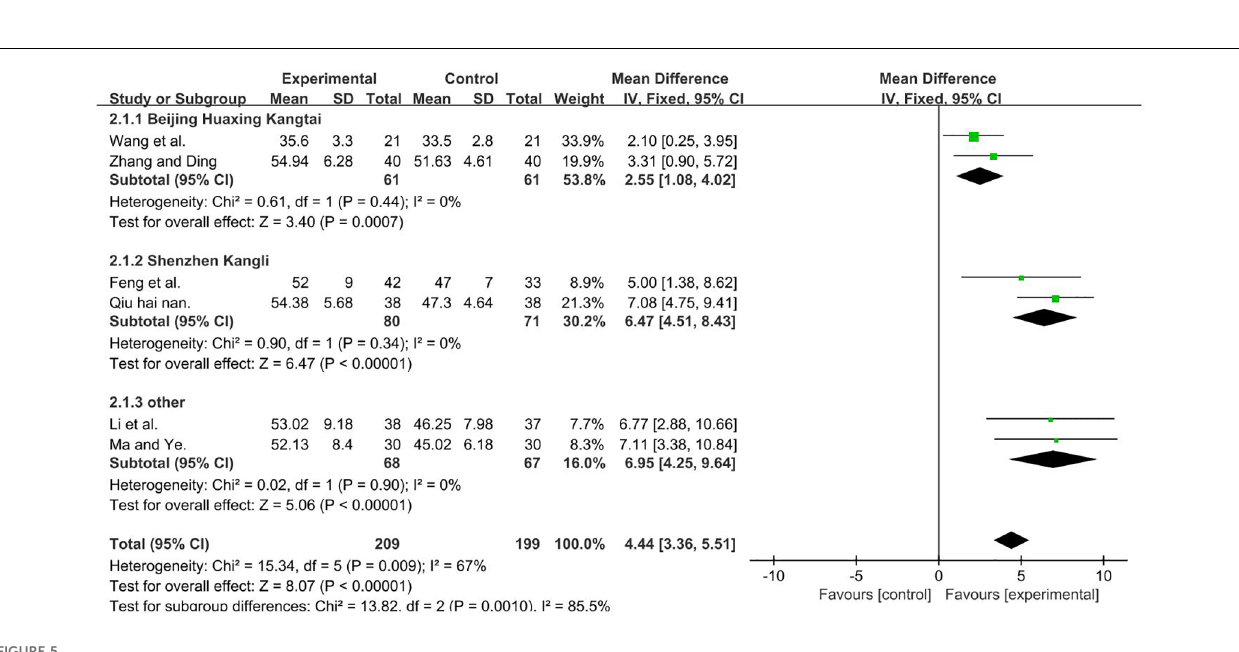
FIGURE 5 Forest plot showing MD (with 95% CI) for GMFM-B of the included studies comparing the experimental and control groups. Note: For the Beijing Huaxing Kangtai subgroup, P =0.44 and I 2 =0%., fi xed-effect model [MD=2.55, 95% CI (1.08, 4.02); P <0.001]. For the Shenzhen Kangli subgroup, P =0.34 and I 2 =0%, fi xed-effect model [MD=6.47; 95% CI (4.51, 8.43); P <0.001]. For the other subgroup, P =0.9, and I 2 =0%, fi xed-effect model [MD=6.95; 95% CI (4.25, 9.64); P <0.001]. The analysis results of the three subgroups were statistically signi fi